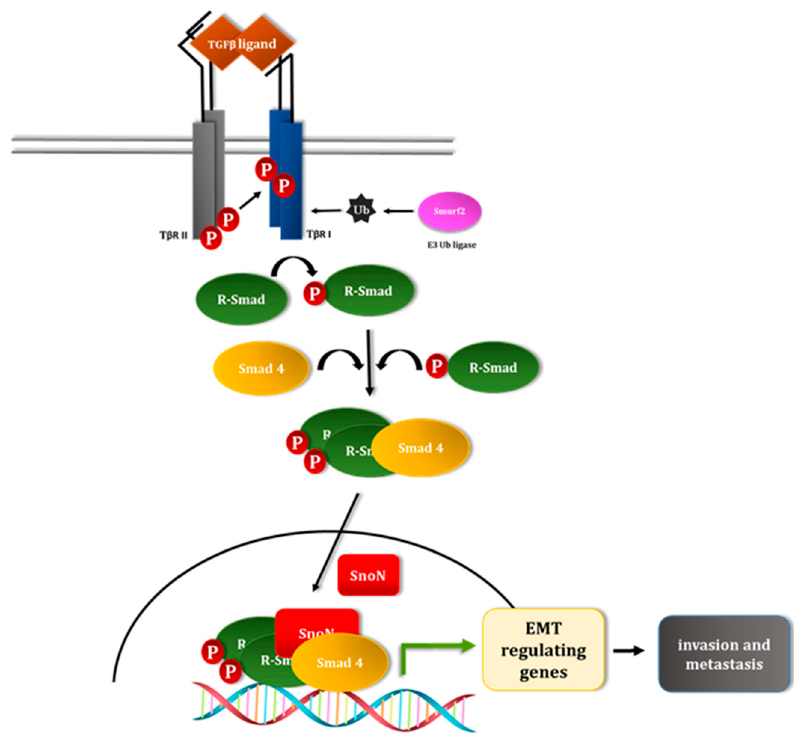
Figure 2. The transforming growth factor beta (TGF β )-smad signaling pathway. The TGF β ligand binds the transmembrane type II ser/thr kinase receptor (T β RII) leading to recruitment of type I ser/thr kinase receptor (T β RI). Within this complex, T β RII transphosphorylates the T β RI within the GS domain which in turn promotes the activation of the T β RI's kinase moiety. The activated ligand-receptor heteromeric complex associate with the Receptor-regulated Smad 2 and 3, whereby the last two C-terminal serine residues within these Smads are targeted by phosphorylation by the T β RI kinase. The TGF β -phosphorylated R-Smad dissociates from the receptor complex and forms a hetero-oligomer complex with the common-partner Smad4, and the complex accumulates in the nucleus. Within the nucleus, the Smad complex binds to specific DNA elements on TGF β -responsive genes and in collaboration with other transcription factors and transcriptional coregulators, including SnoN, can positively or negatively regulate the expression of these genes and consequent responses including EMT. The ubiquitin E3 ligase Smurf2 is recruited to the activated TGF β receptors leading to their ubiquitin-mediated degradation and suppression of TGF β signaling pathway.